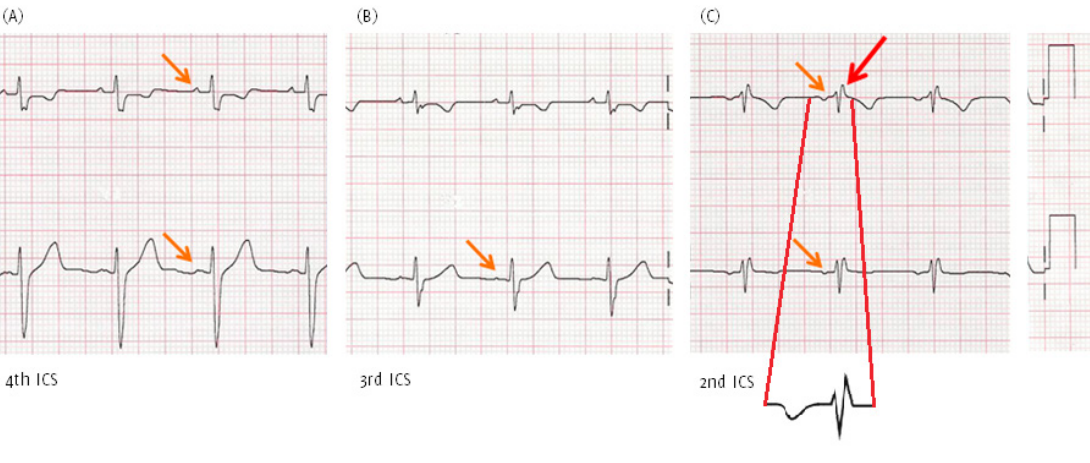
Figure 3. The P wave is positive in V1-V2 (arrows) when the electrodes are correctly placed (A) on the 4th in- tercostal space (ICS). When V1-V2 electrodes are misplaced on the 3rd ICS (B), the low-voltage or flattened P wave in V2 (arrow) is the tell-tale sign of high placement. And when the V1-V2 electrodes are misplaced on the 2nd ICS, one sees a negative P wave and rsR’ (red arrow) which indicate high placement of the electrodes (C).